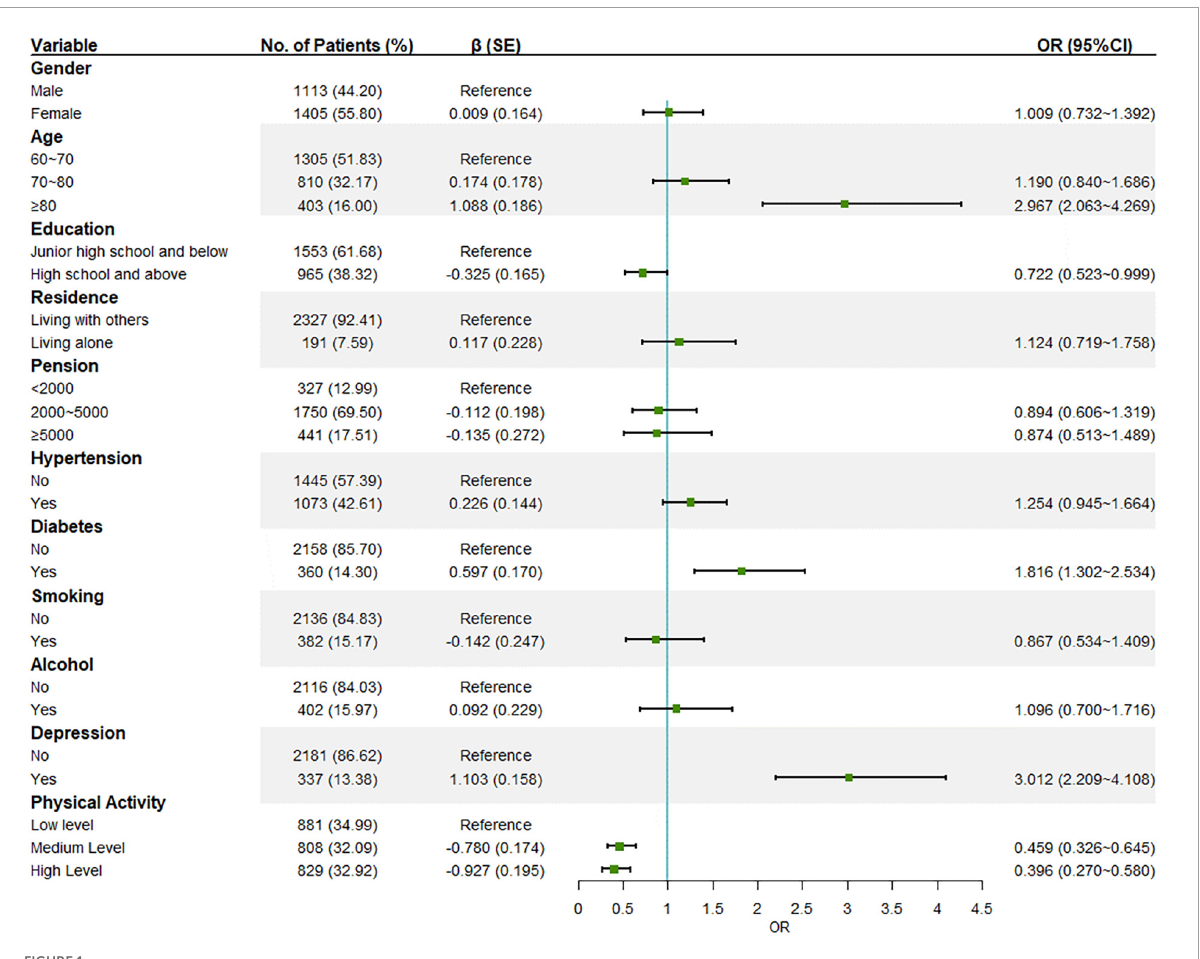
FIGURE1 Logistic regression with MCI screening results as the dependent variable.